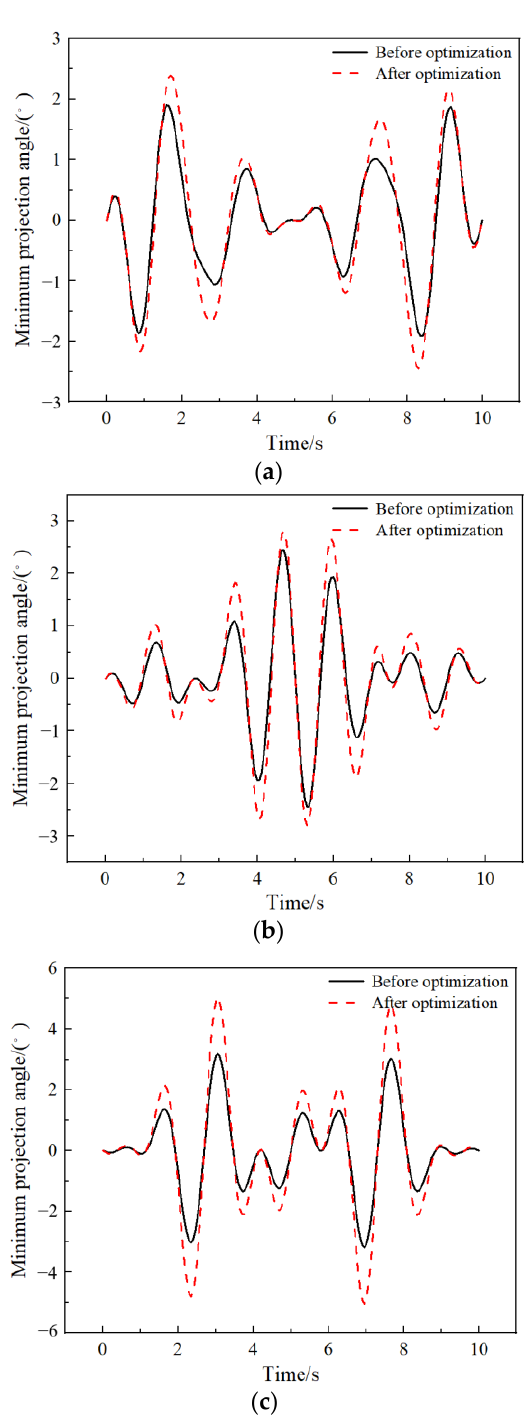
Figure 13. Minimum projected angle: ( a ) X axis; ( b ) Y axis; ( c ) Z axis.